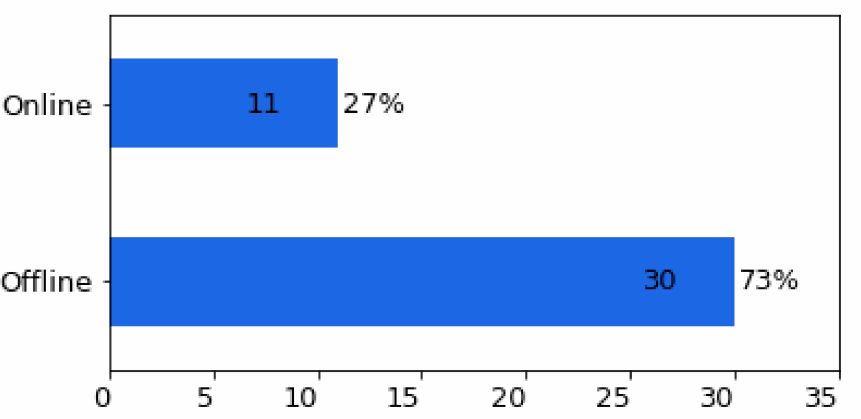
Figure 16. Breakdown of evaluation approaches.